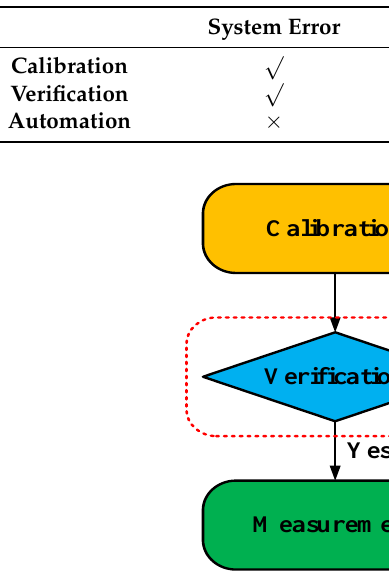
Table 4. Measurement errors and suppression means.